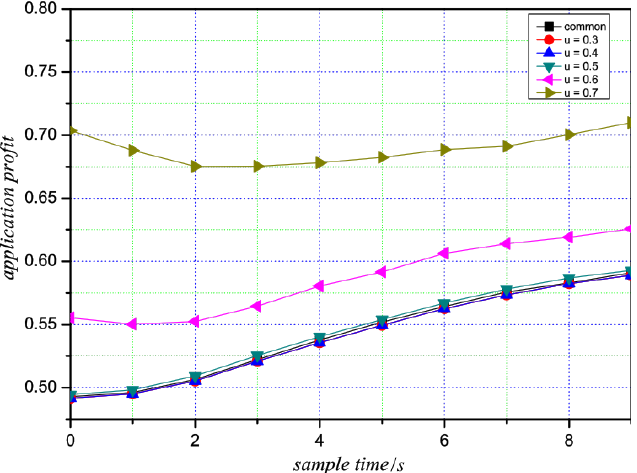
Figure 10. Application benefit compared by different values of µ .